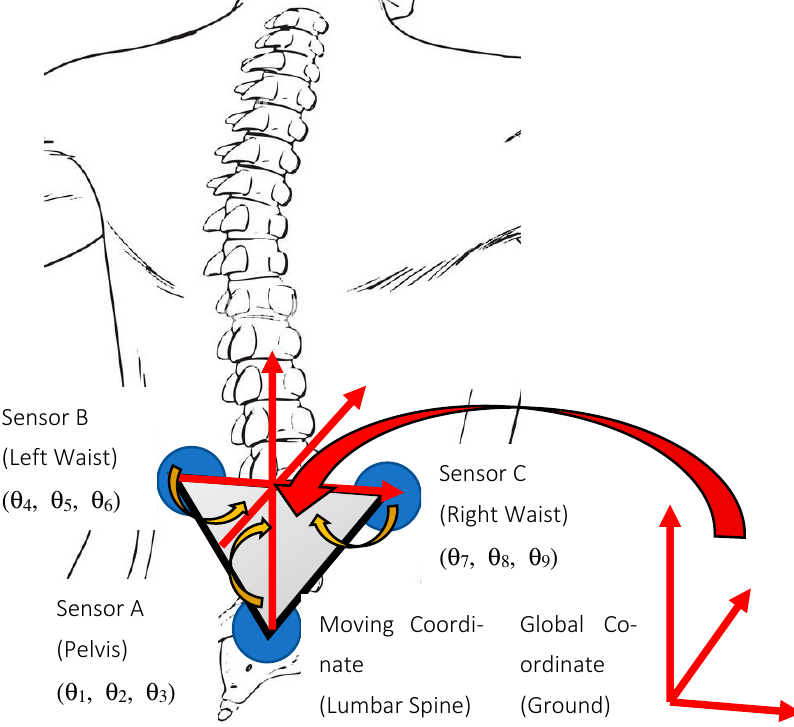
Figure 1. Approach to calculate relative motion to the ideal position and transform the coordinate system of the lumbar sensors (B and C) with the pelvis sensor (A).